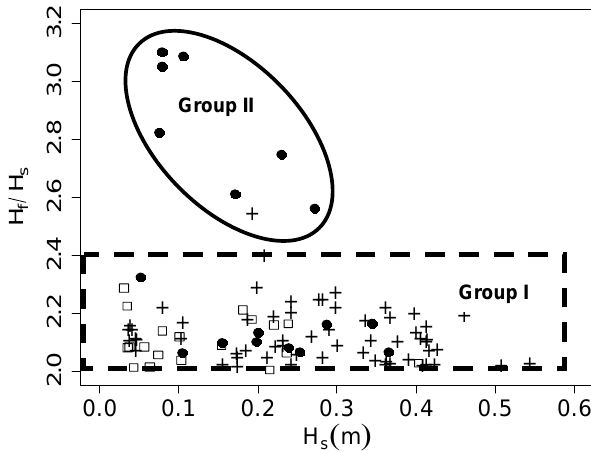
Fig. 5. Amplification factor plotted against significant wave height Figure 5. Amplification factor plotted against significant wave height for positive (crosses), for positive (crosses), negative (circles) and sign-variable (squares) negative (circles) and sign-variable (squares) freak waves. freak waves.